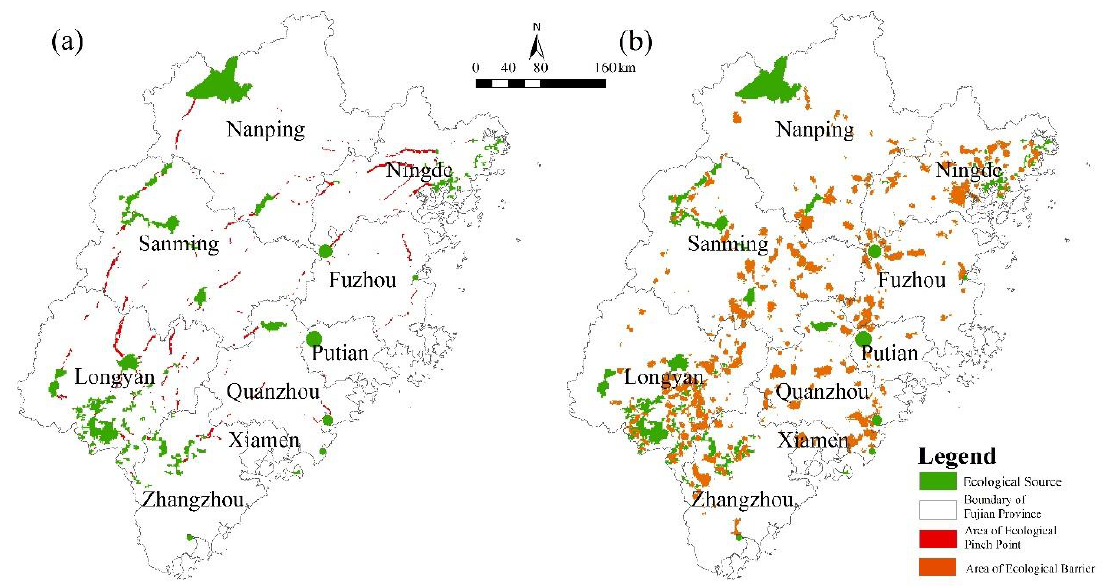
Figure 7. Distribution maps of ( a ) ecological pinch points and ( b ) ecological barriers.